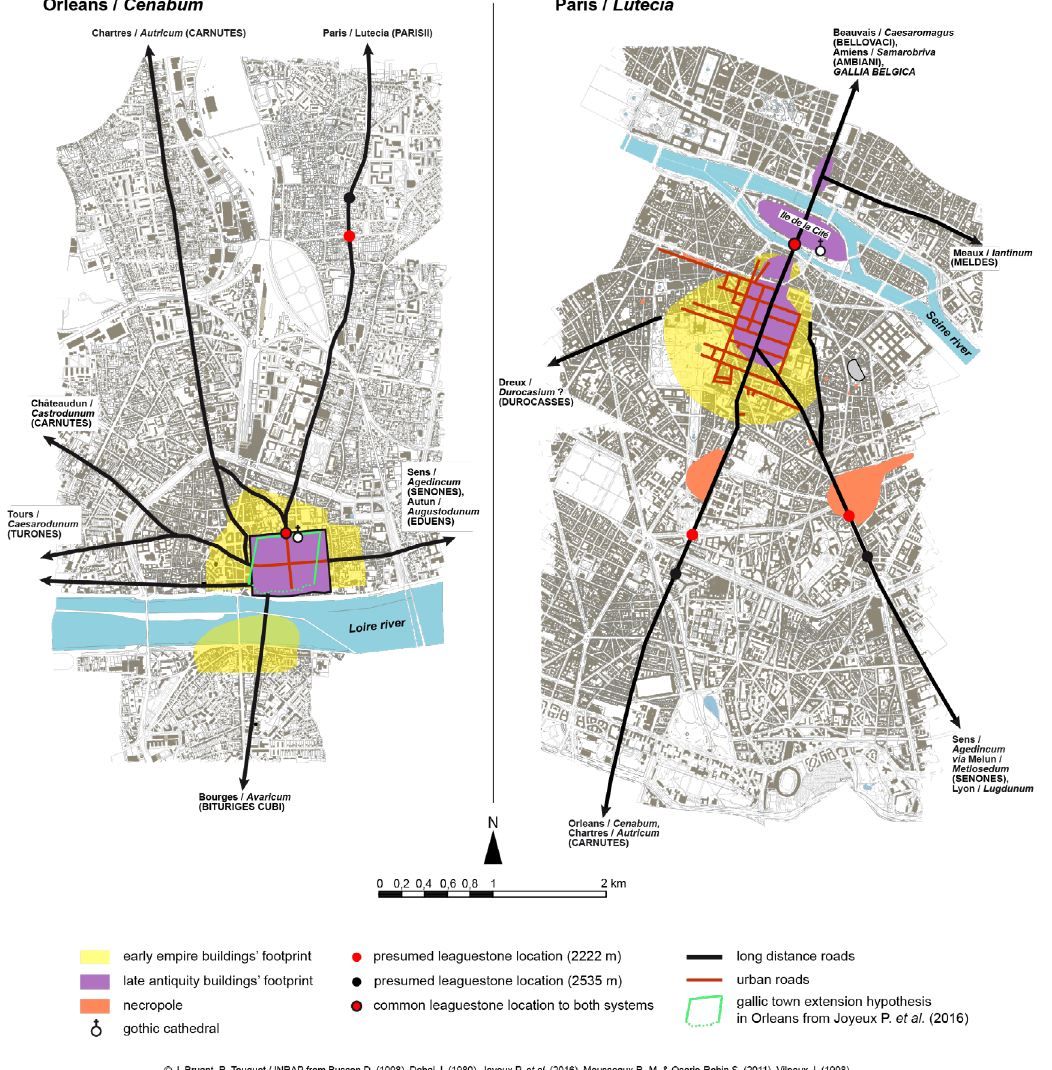
Figure 23. Presumed leaguestone location (2535 m and 2222 m systems) superimposed upon the topography of Orleans/ Cenabum and Paris/ Lutecia . © J. Bruant, S. Eusèbe, R.